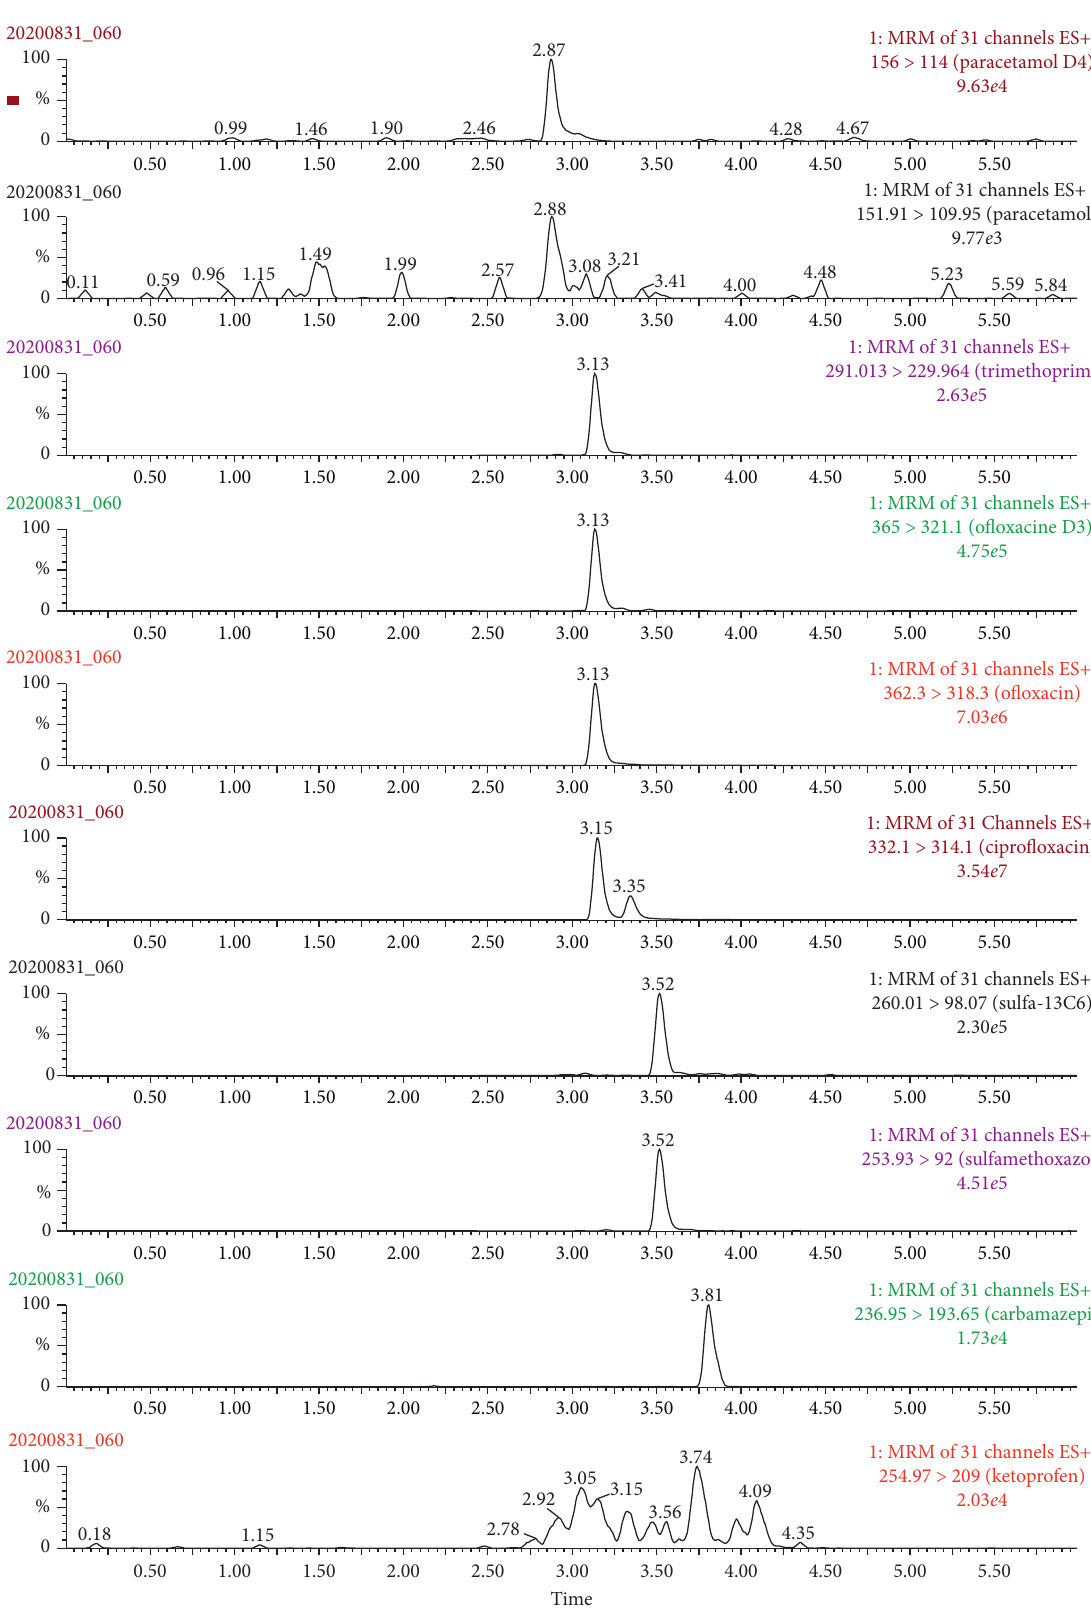
Figure 6: Extracted ion chromatograms of all target compounds in real hospital wastewater